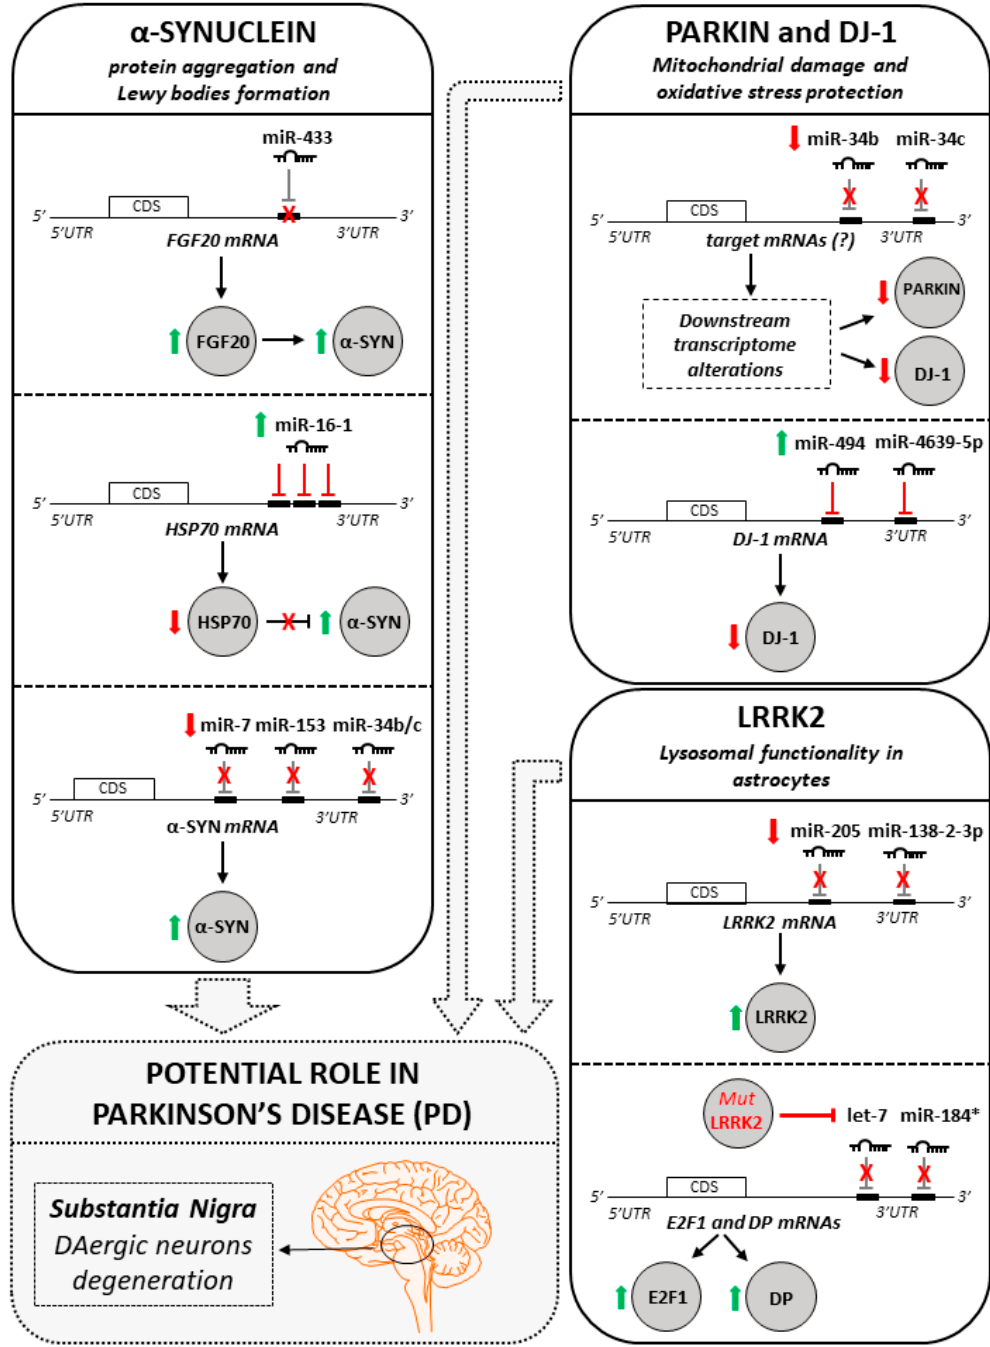
Figure 2. Regulation of PD-related genes mediated by miRNAs. Schematic representation of miRNA-mediated dysfunction networks in PD-related genes. Inhibitory arrows indicate how miRNAs act on their target sequence. Red crosses on inhibitory arrows indicate PD-related pathogenic processes blocking miRNA binding on their targets. Red crosses on miRNA target binding sites indicate an SNP interfering with the direct miRNA binding on their specific target sequence. Green and red thick arrows indicate, respectively, an upregulation or downregulation of a given miRNA or protein.